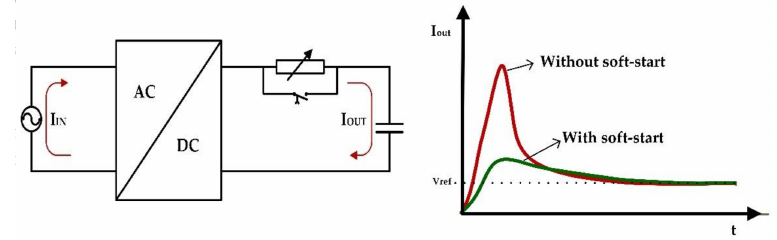
Figure 1. Inrush current without soft-start and with soft-start.